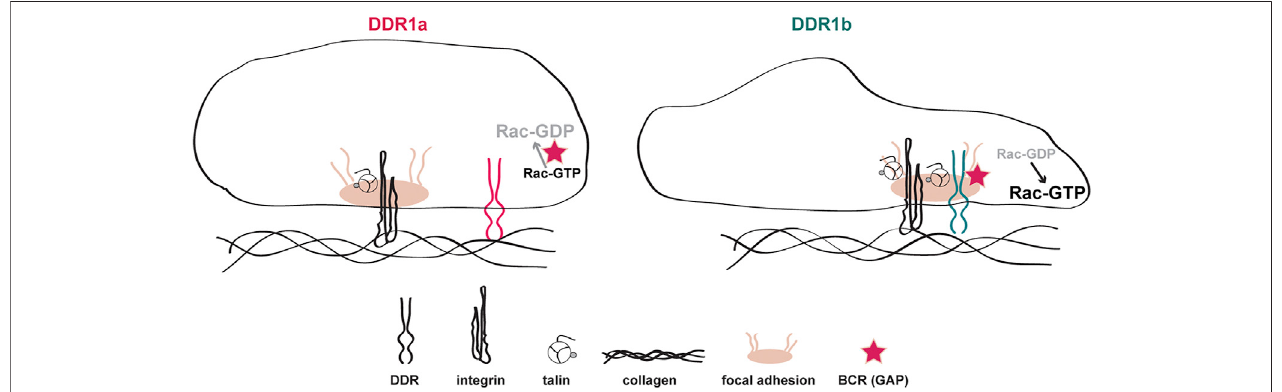
FIGURE 6 | Schematic representation of collagen I-mediated DDR1a vs DDR1b function. In cells expressing DDR1a and exposed tocollagen I, this receptor does not co-localize with activated integrins in focal adhesions. In contrast, in cells expressing DDR1b and exposed to collagen I, this receptor binds more ef fi ciently to talin, co-localizes with activated integrins in focal adhesions, and enhances integrin β 1-mediated cell migration. In addition, DDR1b binds the GAP BCR thus enhancingRac1 activation and migration.